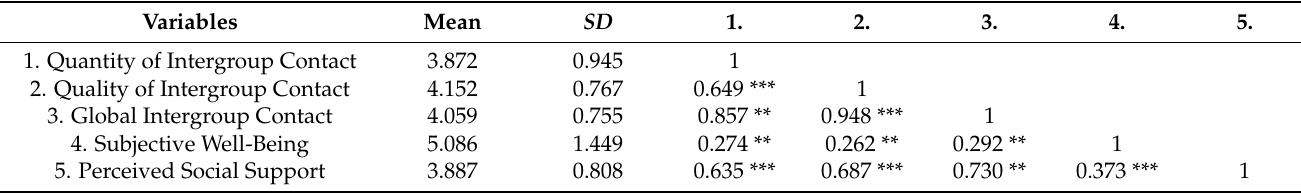
Table 1. Descriptive statistics and analysis ( N = 860).